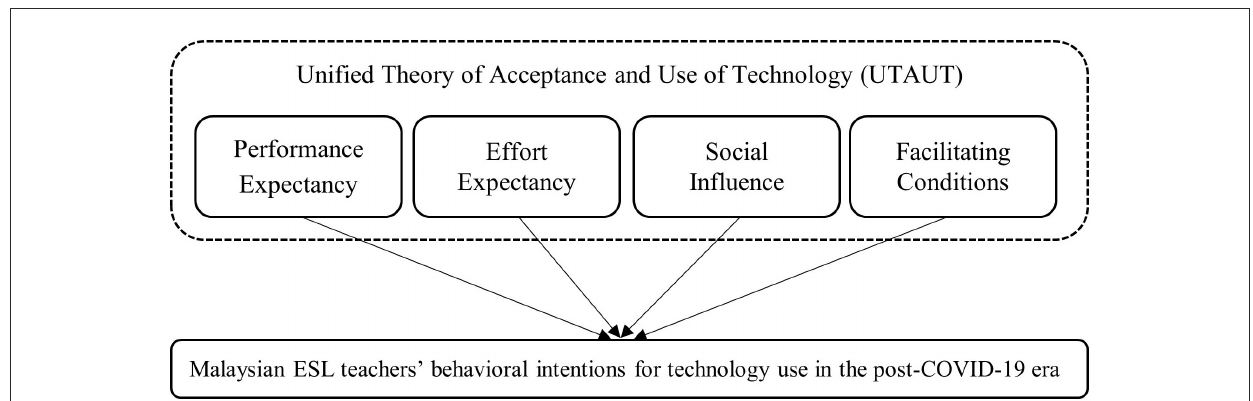
FIGURE1 Conceptual framework of the